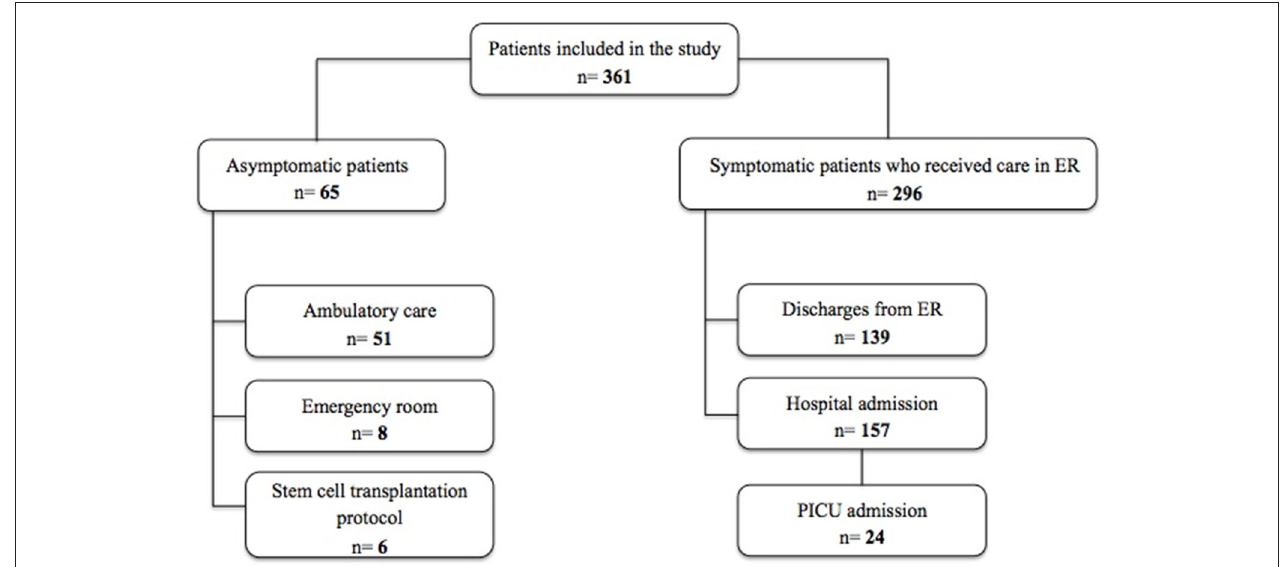
FIGURE 1 | Flowchart of the included